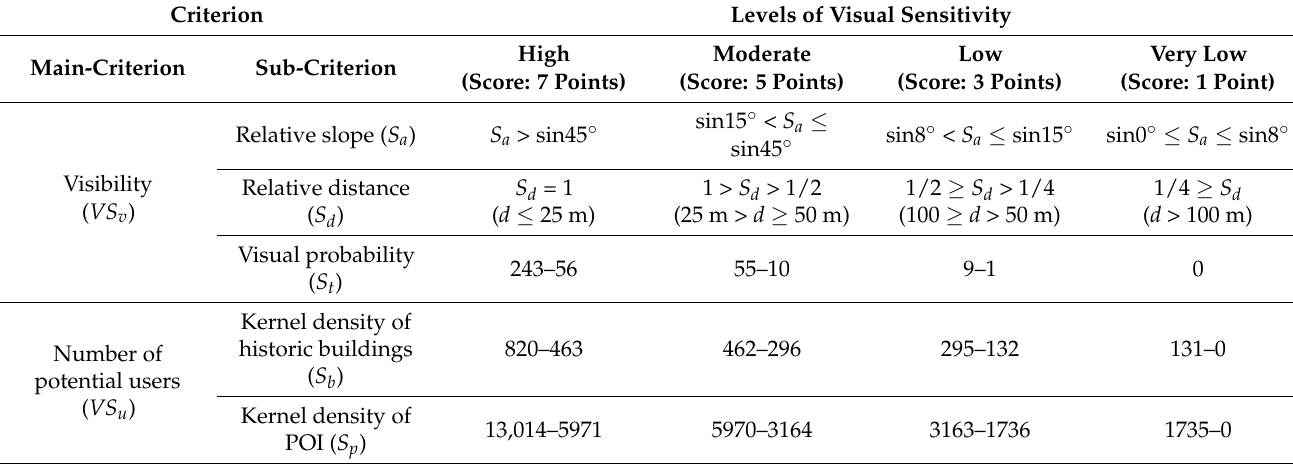
Figure 3. The hierarchy of the landscape visual sensitivity assessment model of Wudadao. Table 1. Classification and assignment of the landscape visual sensitivity assessment criterion.